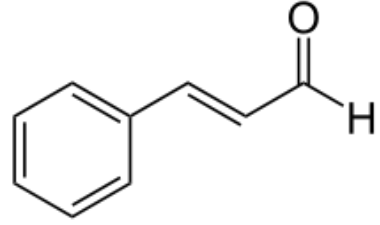
Figure 1. Chemical structure of c i nnamaldehyde.